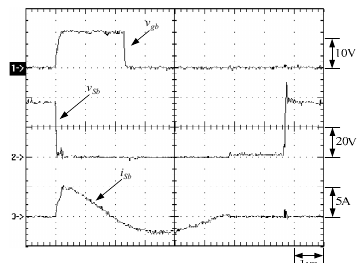
Figure 32. Waveforms pertaining to S a at the rated load: (1) v ga ; (2) v Sa ; and (3) i Sa .